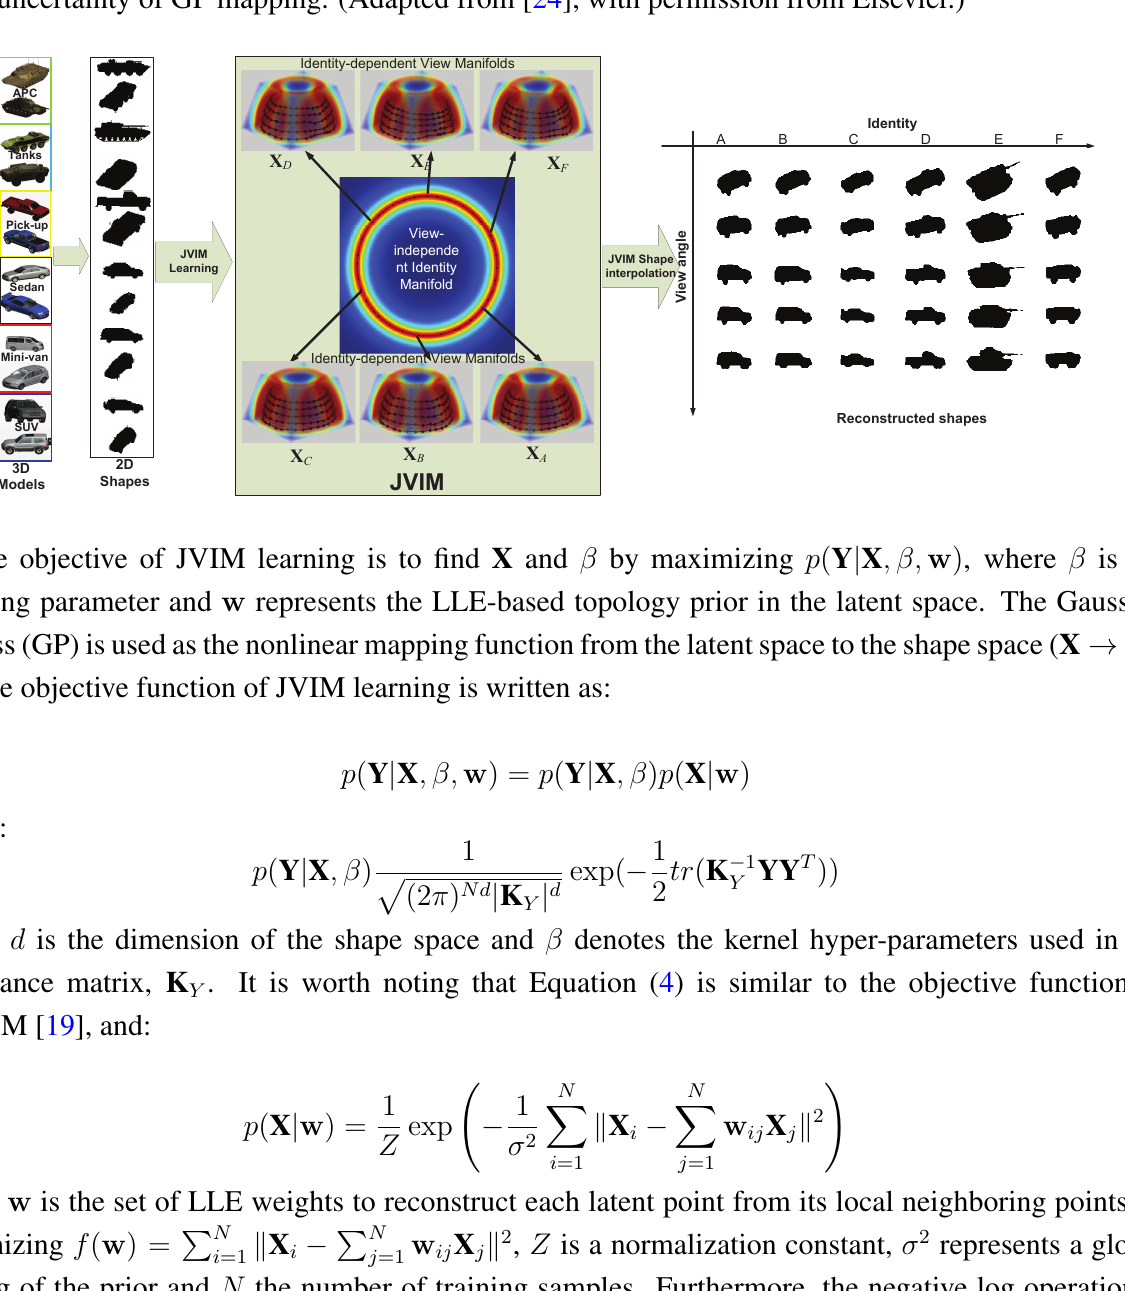
Figure 3. JVIM learning and shape interpolation, where one view-independent identity manifold and six identity-dependent view manifolds are color-coded according to the uncertainty of GP mapping. (Adapted from [24], with permission from